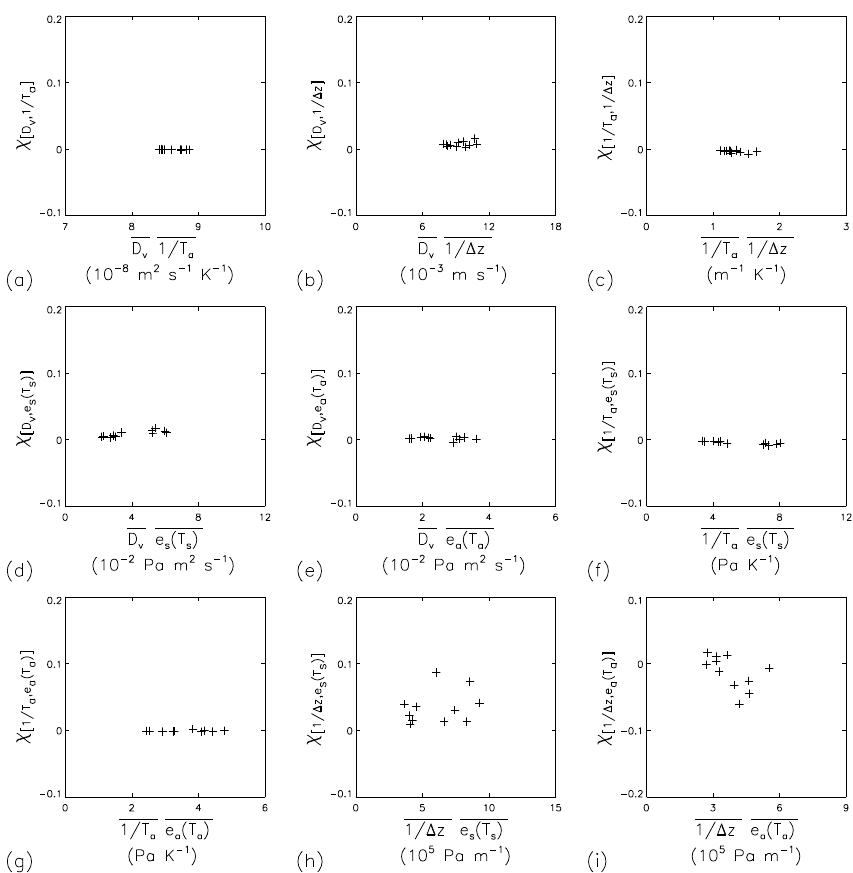
Fig. 3. Relation between the covariance-based correction factors (per Eq. 8) and the relevant product of the means for all nine combination for 11 months as follows: (a) D v , 1 ; (b) D , 1 , (c) 1 , 1 ; (d) D v , e s (T s ) ; (e) D v , e a (T a ) ; (f) 1 1z 1z T a T a , e a (T a ) ; (h) 1 , e s (T s ) ; (i) 1 , e a (T a ) (g) 1 1z 1z T a